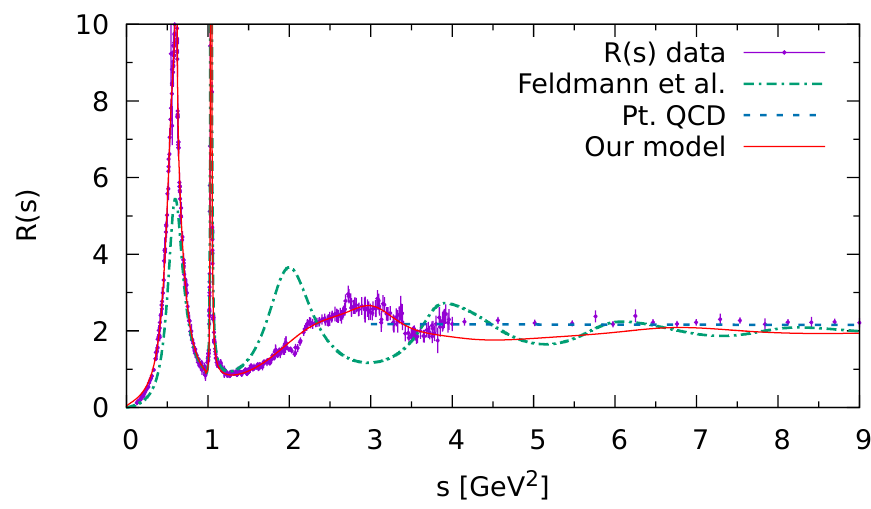
Figure 2 . R ( q 2 ) described by eq. (3.8) with parameters given in table 1 (solid line). Results from the model of ref. [6] are also shown for comparison (dash-dotted line). The perturbative QCD result at four loops with N = 3 in the chiral limit is also shown (dashed f